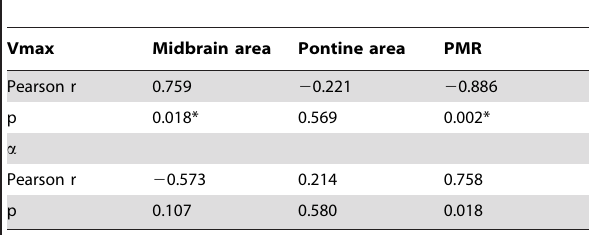
Table 3. Correlations of peak velocity-related parameters with brainstem areas.